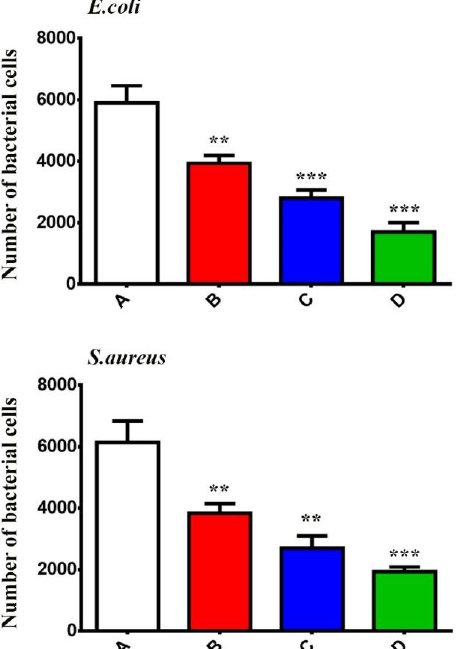
Figure 12. Illustrates the decrease interaction of bacterial strains with REF cells pre-treated with GONPs, GONPs–PEG, and GONPs–PEG– N. sativa . ( A ): control REF cells infected with bacterial strains, ( B ): REF cells pre-treated with GONPs then infected with bacterial strains, ( C ): REF cells pre-treated with GONPs-PEG then infected with bacterial strains, ( D ): REF cells pre-treated with GONPs –PEG- N. sativa then infected with bacterial strains. The values are shown as the mean ± SEM. ** p < 0.005, *** p <